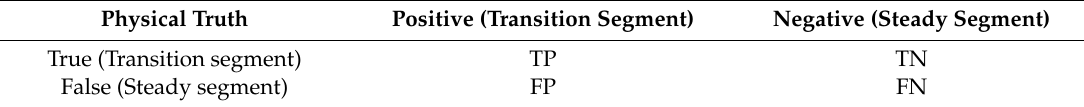
Figure 5. The probability density functions (PDFs) of the two hypotheses. Table 1. The confusion matrix for segmentation.